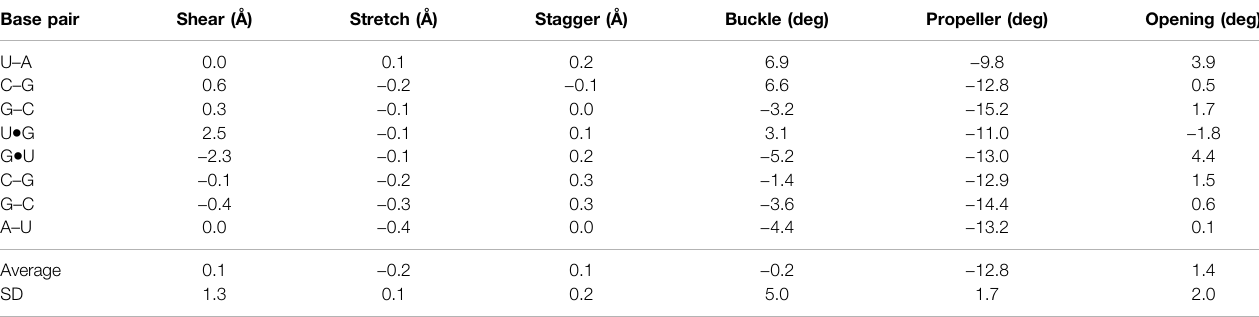
TABLE 4 | Simple base-pair parameters of the r(UCGUGCGA) 2 duplex based on RC8-YC6 vectors calculated using the 3DNA server, v2.4.3-2019apr06 (Lu and Olson, 2003; Li et al.,